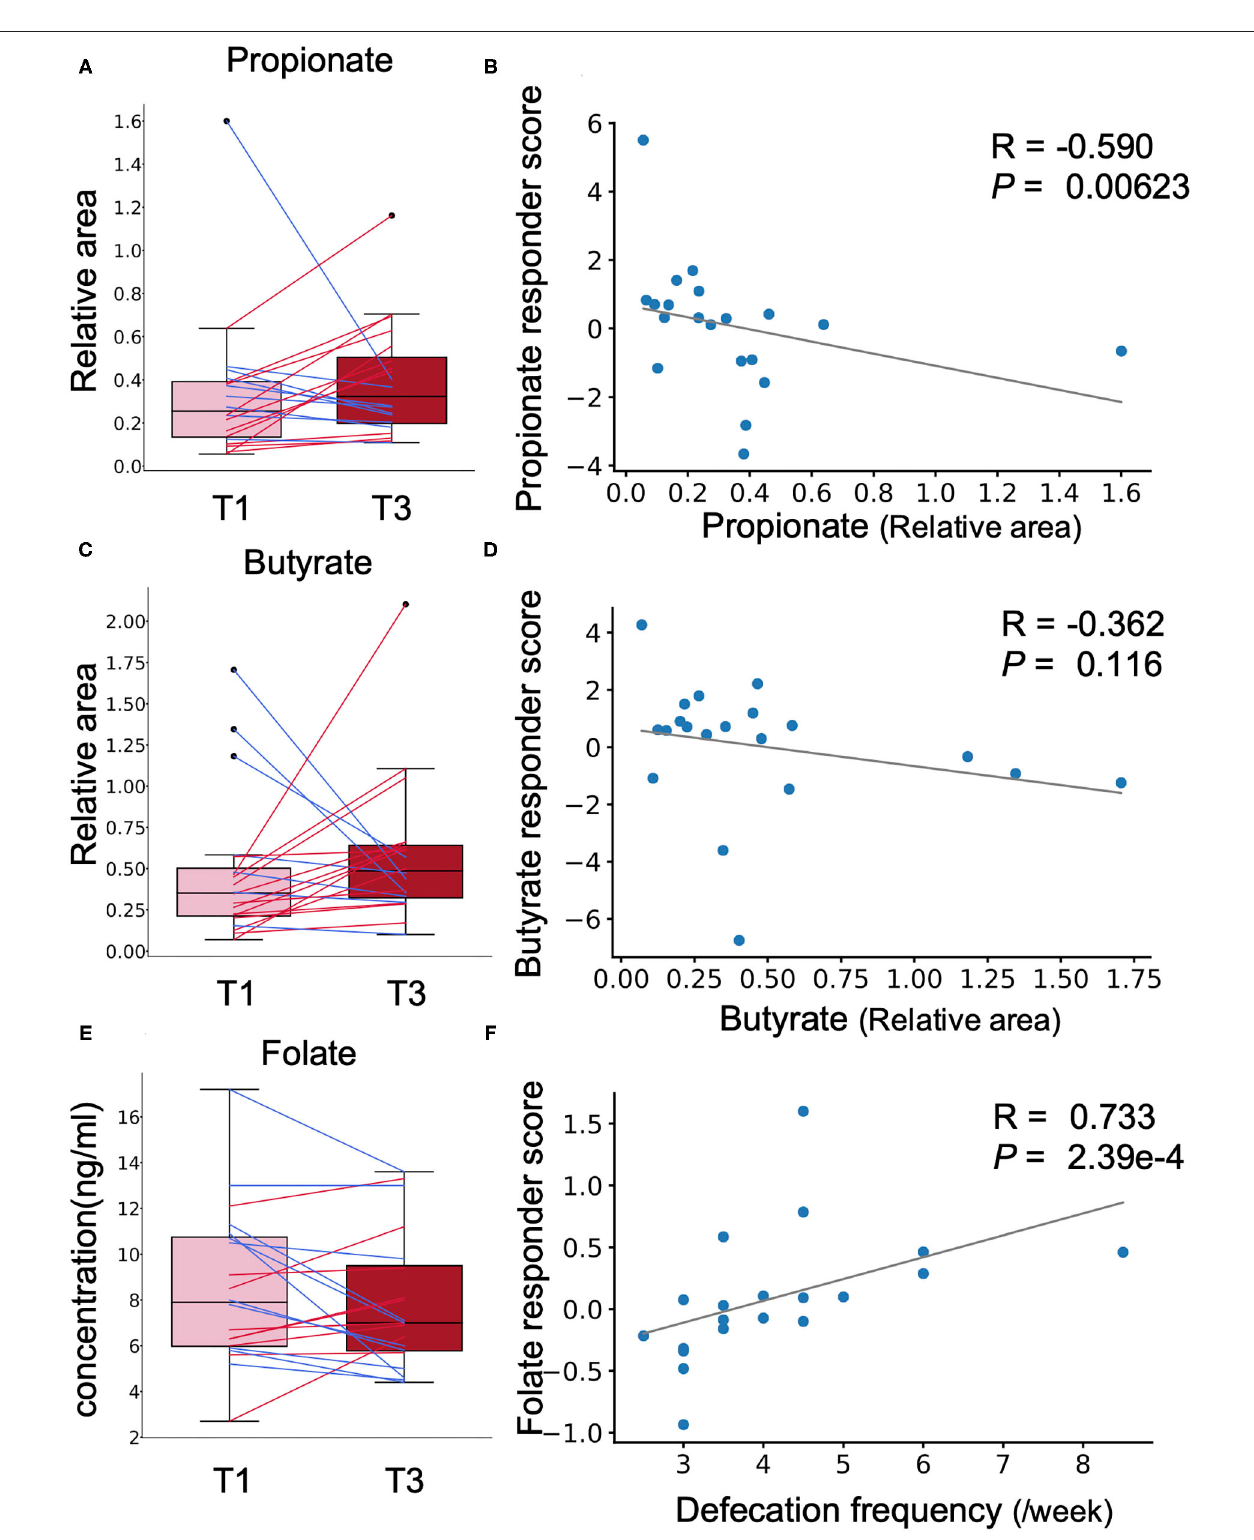
FIGURE 4 | The effect of Chlorella intake depends on intestinal environmental factors at baseline. (A,C,E) Box plots representing the distribution of faecal propionate (A) , butyrate (C) , and blood folate (E) concentrations. The relative area shows the peak area ratio of samples compared to the internal standard, which represents the concentration of the corresponding metabolite. No significant difference was detected (Wilcoxon signed-rank test). (B,D,F) The X -axis indicates the value at baseline. The Y -axis indicates the responder score of each metabolite/blood test item. Correlation was determined using the Spearman coefficient. The grey line shows the approximated